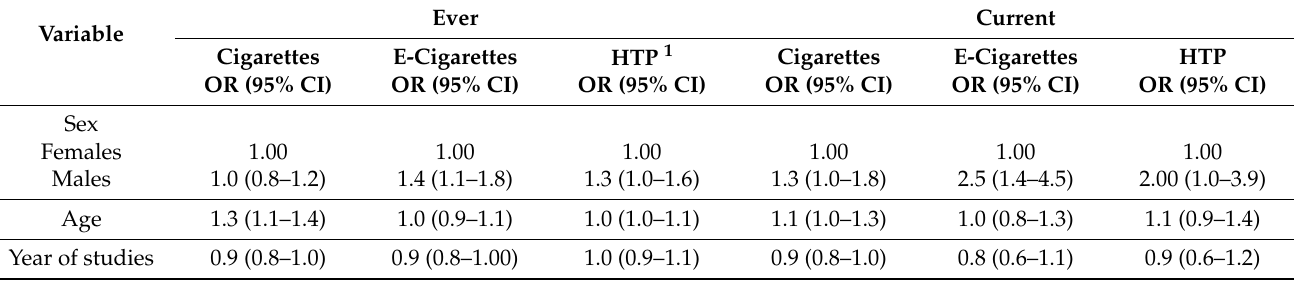
Table 4. Adjusted associations between personal characteristics and nicotine containing product use ( n = 1344).